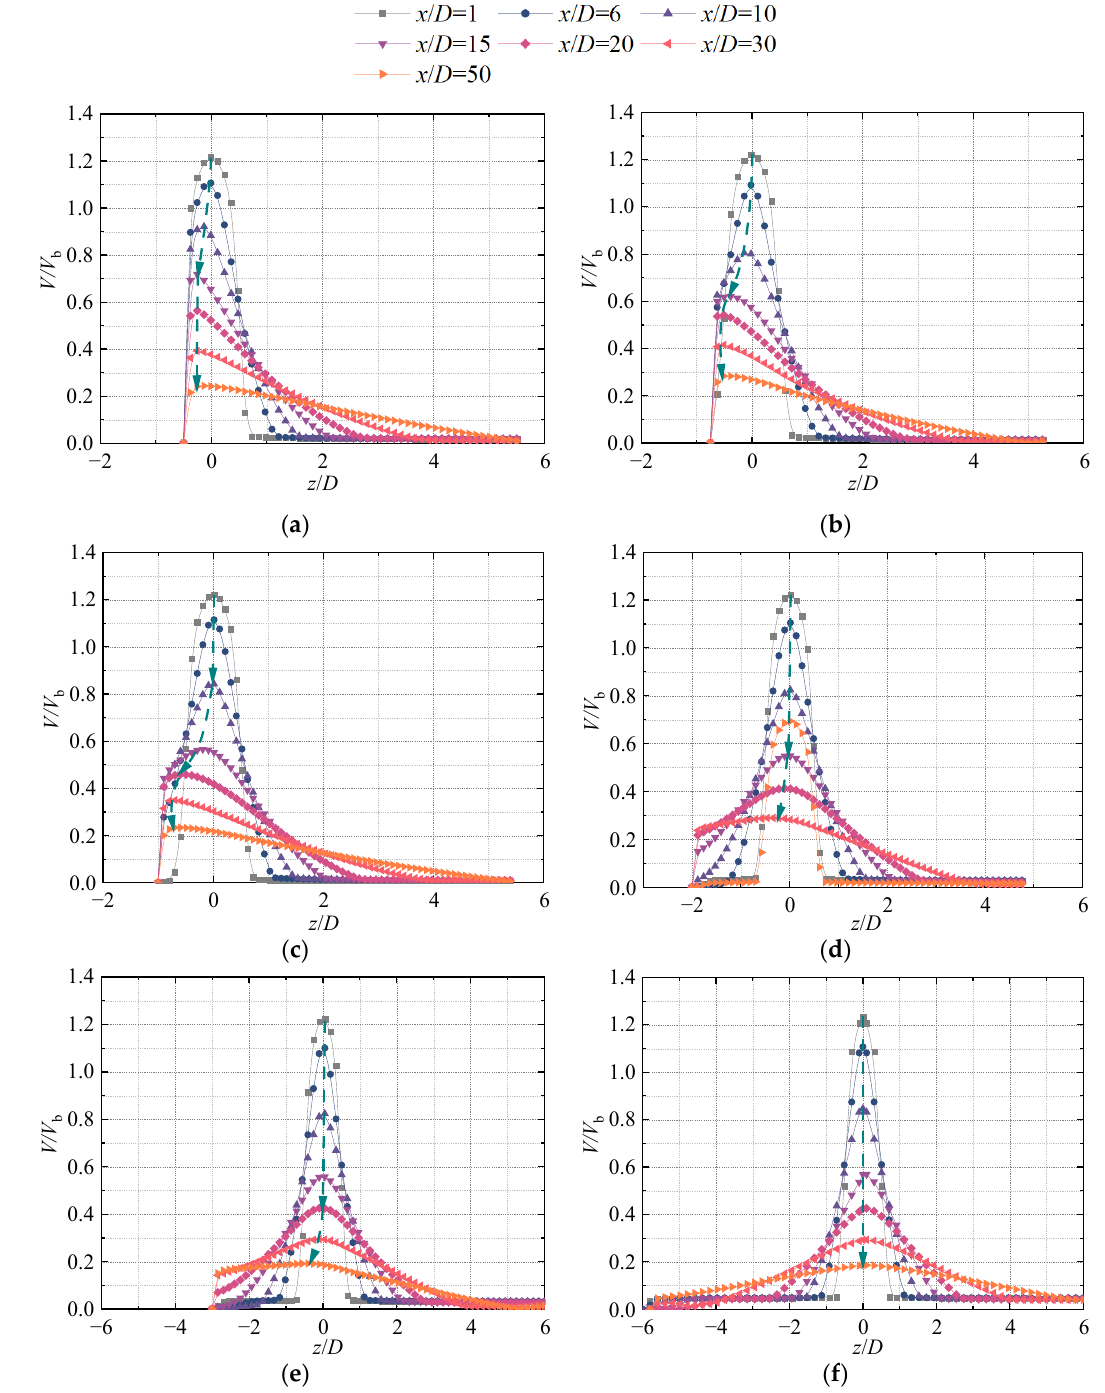
Figure 10. Axial V / V b distribution in the mid-section ( oxz plane) of the jet under different H / D conditions: ( a ) H / D = 0.5; ( b ) H / D = 0.75; ( c ) H / D = 1; ( d ) H / D = 2; ( e ) H / D = 3; and ( f ) H / D = 6. Figure 11 shows the distribution of V / V b along the axis of the horizontal jet at different horizontal heights ( Re = 35,100). The trends are similar at different horizontal heights. In the initial range (0 ≤ x / D ≤ 6), the values of V / V b decrease slowly from 1.23 to 1.15. When the jet further develops, it decays rapidly to about 0.4 in the region of 6 ≤ x / D ≤ 25. As x / D continues to increase, the rate of decrease in V / V b slows down and gradually fluctuates around 0.2. At the same time, due to the influence of the bottom wall, the mixing effect with the ambient fluid below the jet is greatly weakened. This is why the values of V / V b